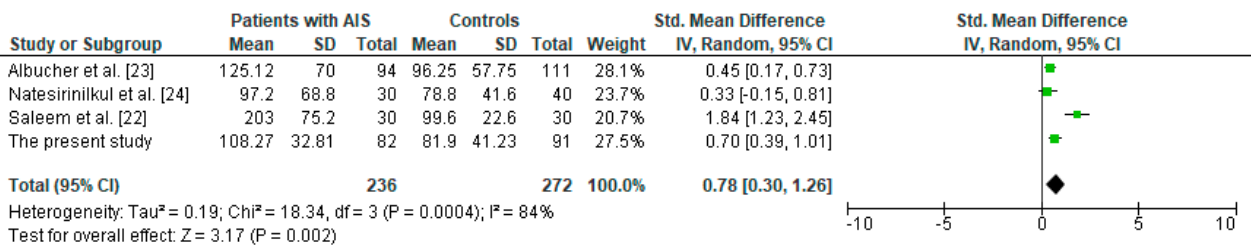
Figure 6. Forest plot for HDL level in the groups of pediatric patients with AIS and controls [22–24]. HDL—high density lipoprotein; AIS—arterial ischemic stroke; CI—confidence interval; I 2 —heterogeneity; df—degrees of freedom.